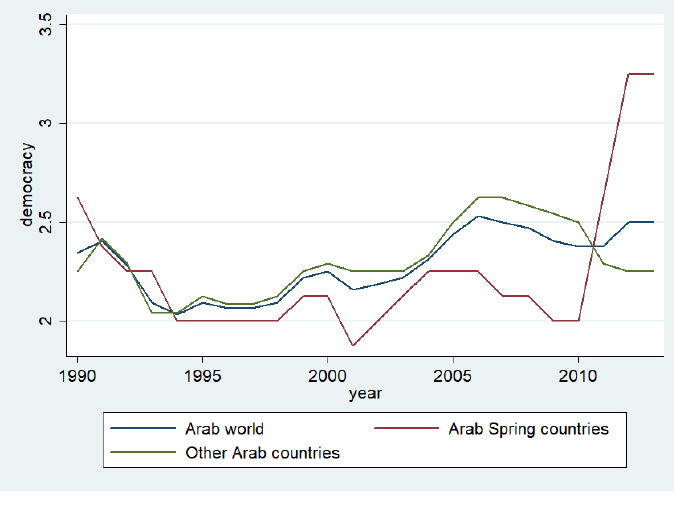
Figure 1: The evolution of the Freedom House index in the Arab World